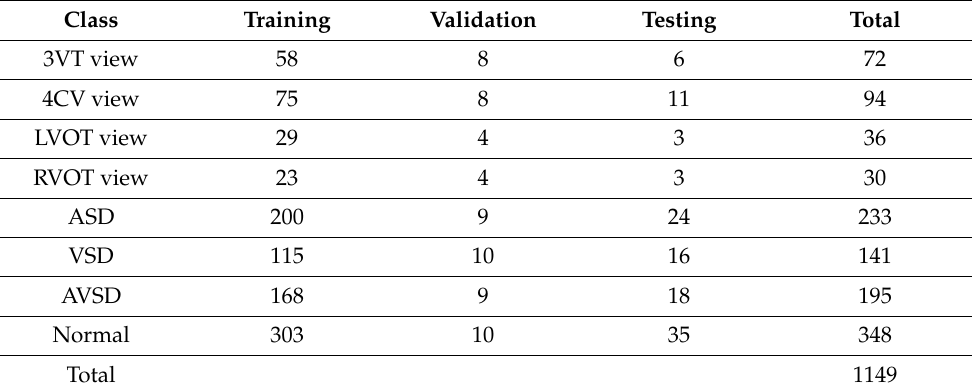
Table 1. Data distribution of fetal heart view and CHDs images. All data are extracted from ultrasound video from normal and abnormal